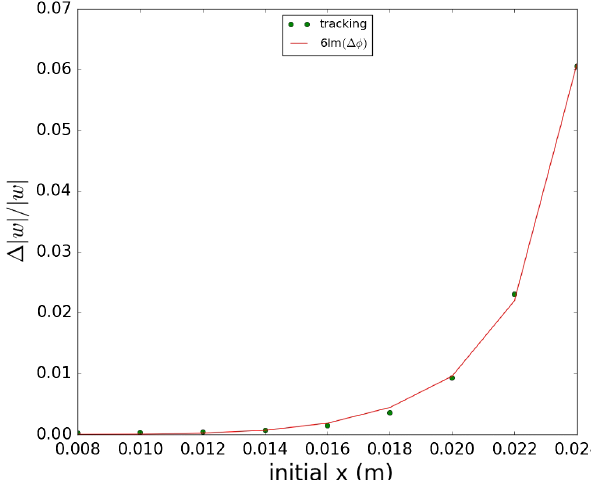
FIG. 7. Difference of maximum and minimum of j Δ w=w j as a function of initial x . Tracking (green) is compared with prediction by (red) multiplied by a constant to obtain agreement with the tracking.